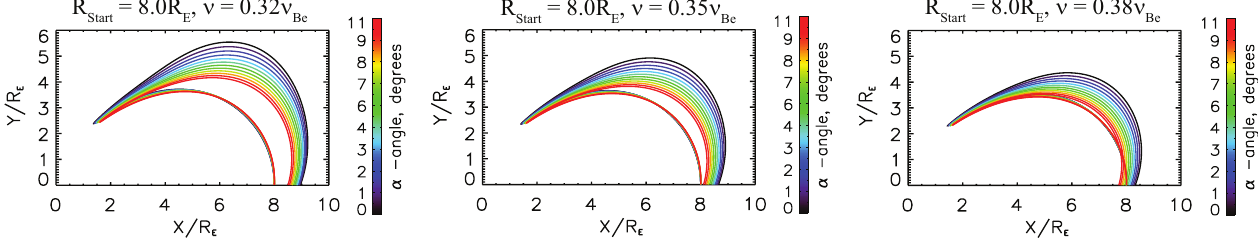
Fig. 7. Whistler ray trajectories for three different wave frequencies. The angle between the magnetic field and whistler’s k -vector is varied in the range 0 ◦ − 11 ◦ . Rays propagate in the meridional plane, ϕ = 0 ◦ . Equatorial plane, R = 8.0R , ν = 0.35 ν Equatorial plane, R = 8.0R , ν = 0.32 ν Start E Be Start E Be